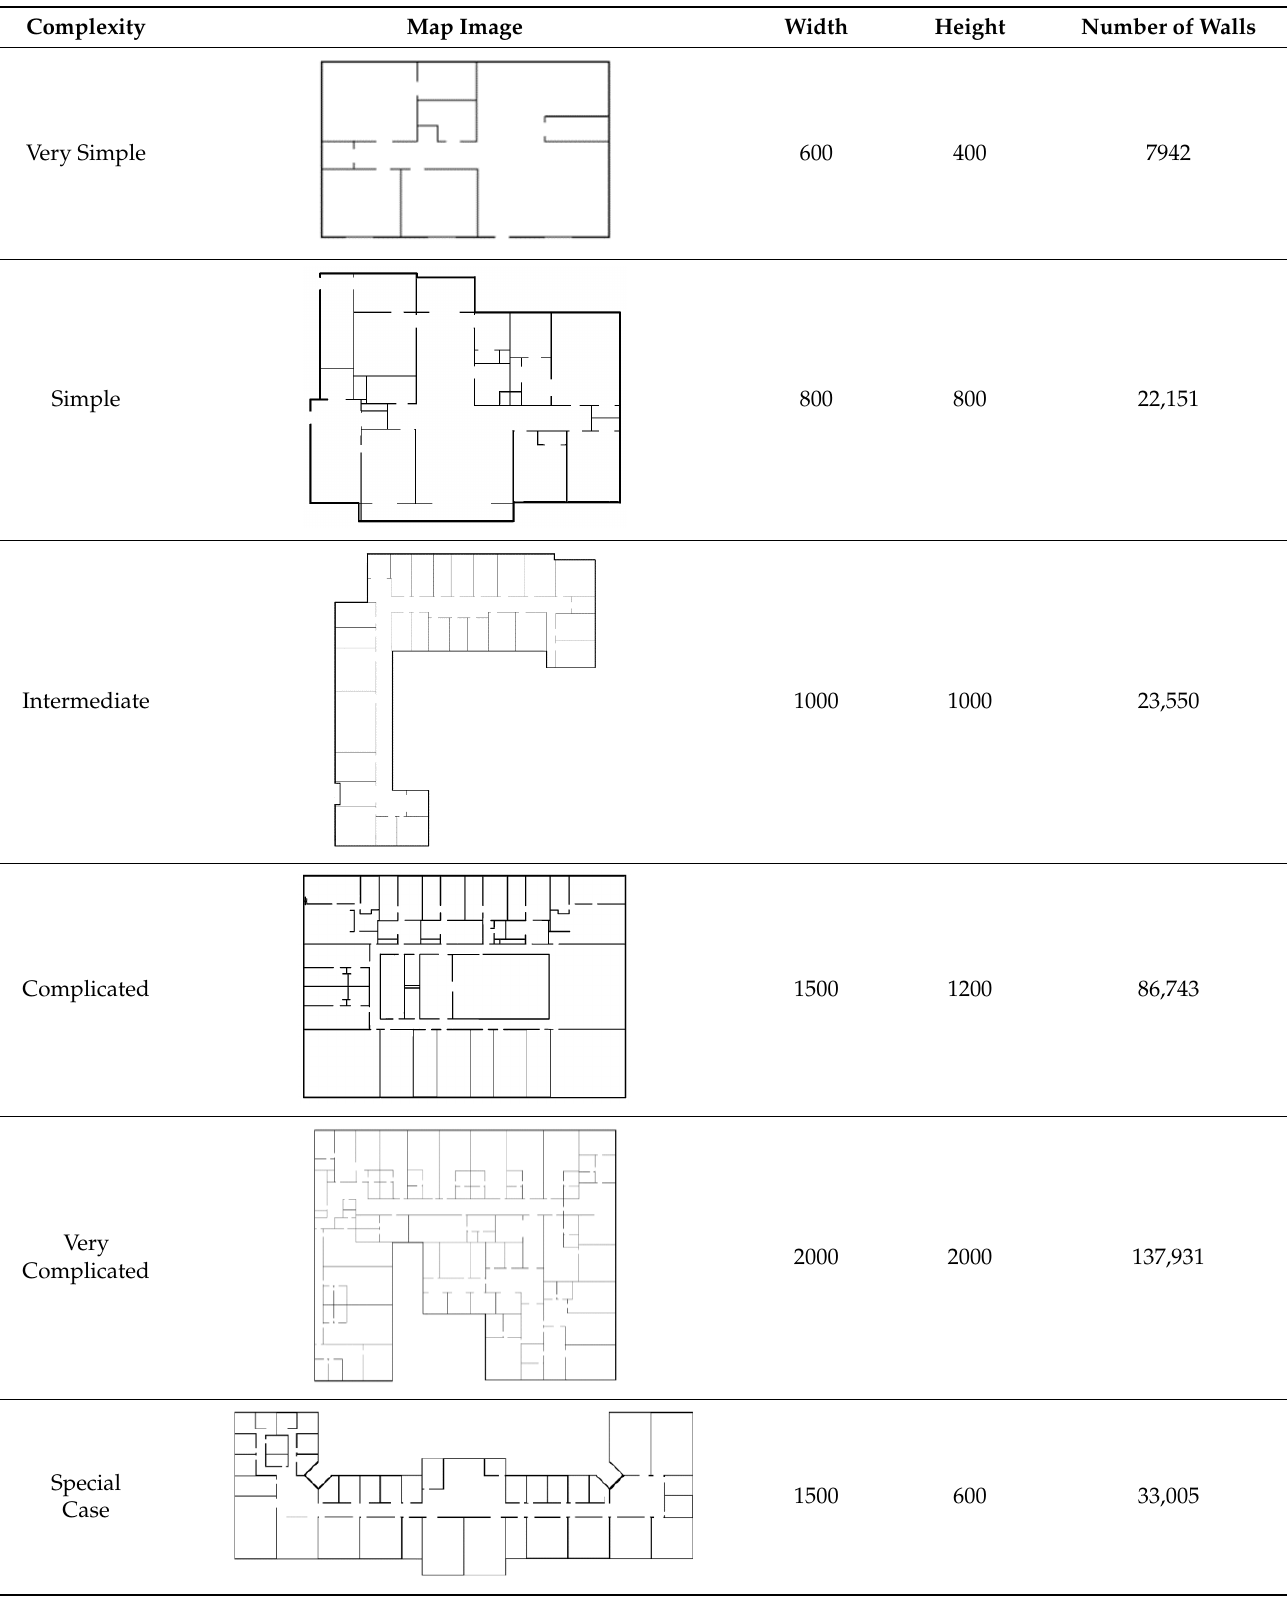
Table 2. Floorplan data.